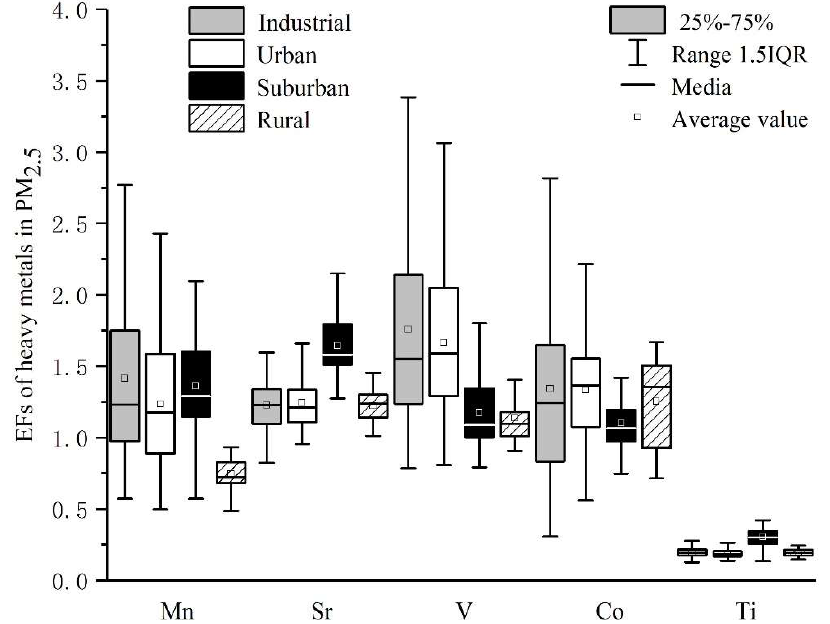
Figure 7. Comparison of the EFs of PM 2.5 -bound heavy metals (EF < 10) in air among four different functional regions in Nanjing city during 2016.